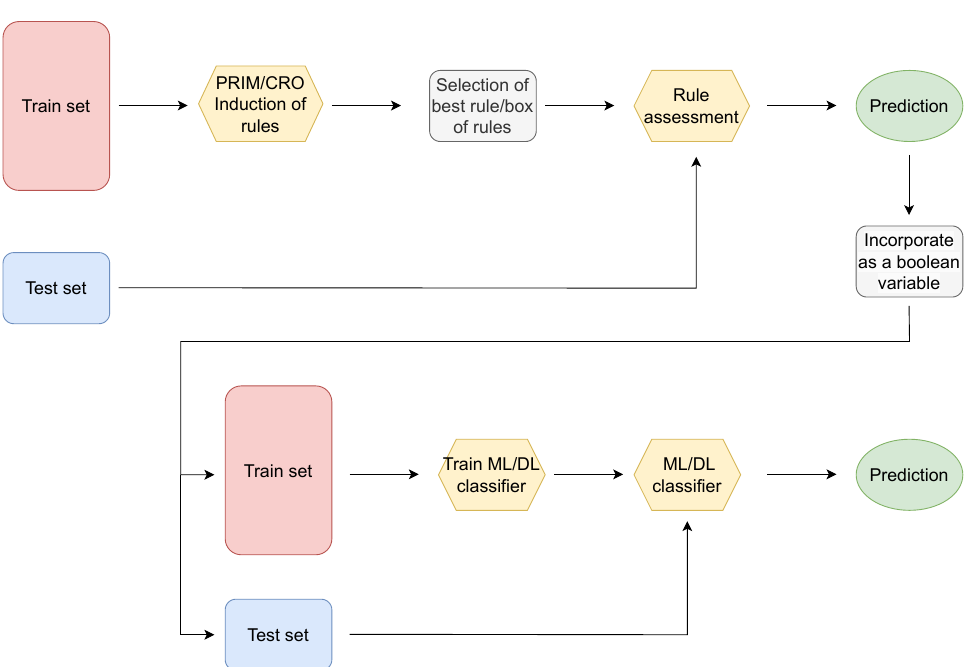
Figure 17. Flow diagram of the proposed methodology in which the induced rules are used as additional predictor variables. Table 3. Different scenarios evaluated when introducing the rule-related information into the database. Case 0 Original training data. Case 1 Addition of PRIM-induced box with highest F1-score on training data. Case 2